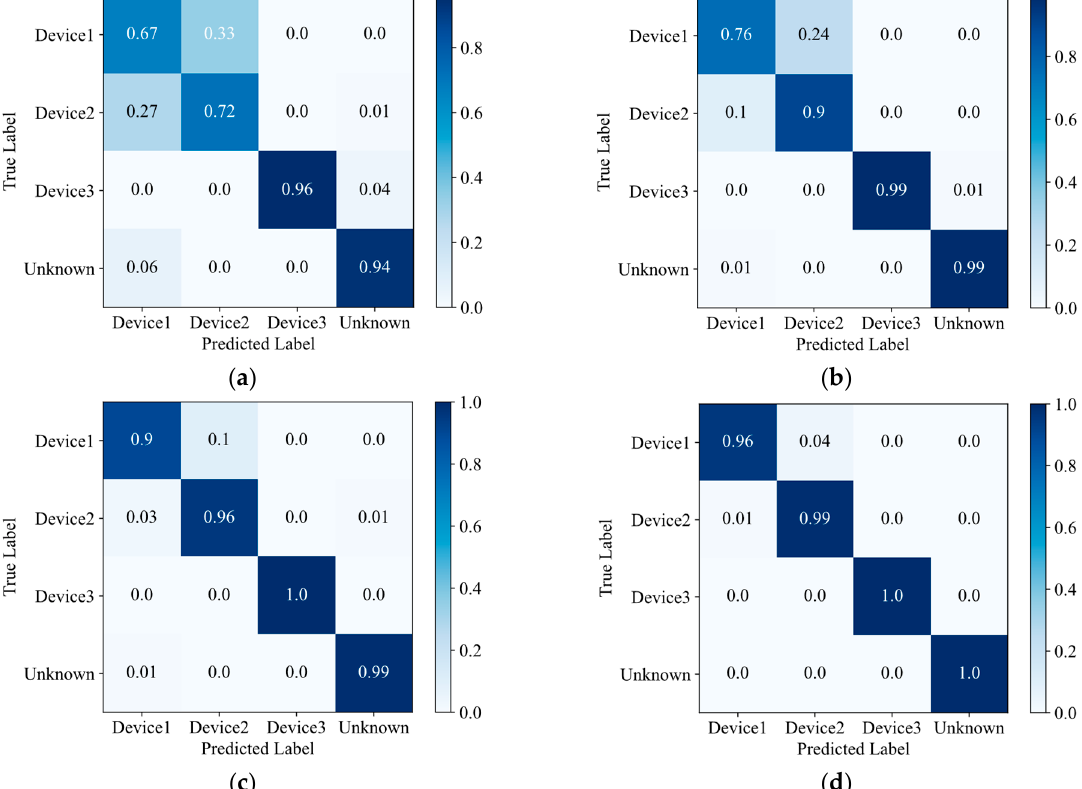
Figure 10. Confusion matrix under different SNRs: ( a ) confusion matrix at − 6 dB; ( b ) confusion matrix at − 2 dB; ( c ) confusion matrix at 2 dB; ( d ) confusion matrix at 6 dB.